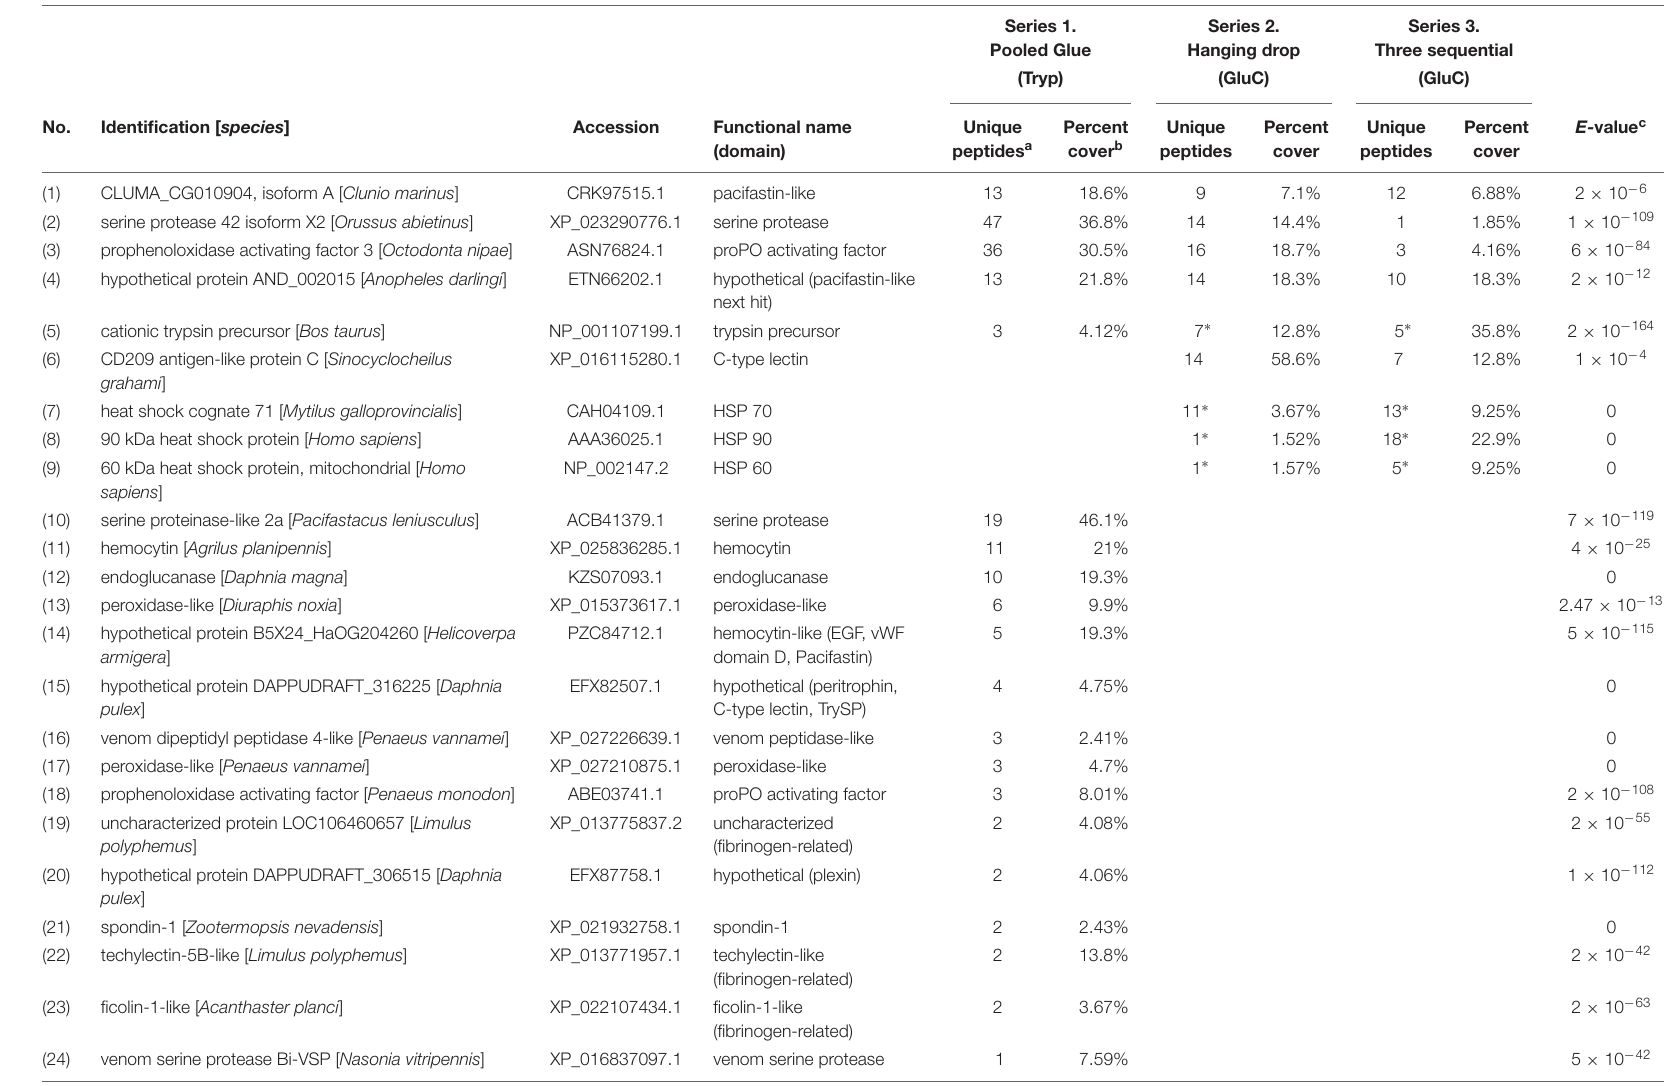
Series columns correspond to each sampling strategy with the enzyme used in digestion indicated in parentheses. Tryp is trypsin and GluC is Glutamyl endopeptidase. For information on the sequence ID refer to Supplementary Table S1 . a Peptide identifications were accepted if they could be established at greater than 99% probability as specified by the Peptide Prophet algorithm (Keller et al., 2002). b Percent cover is the sequence coverage by peptides identified. c E-value represents the alignment of the sequence identified with the top protein hit in the NCBI nr database. ∗ Indicate peptide hits found when searching for specificity with trypsin on GluC-digested